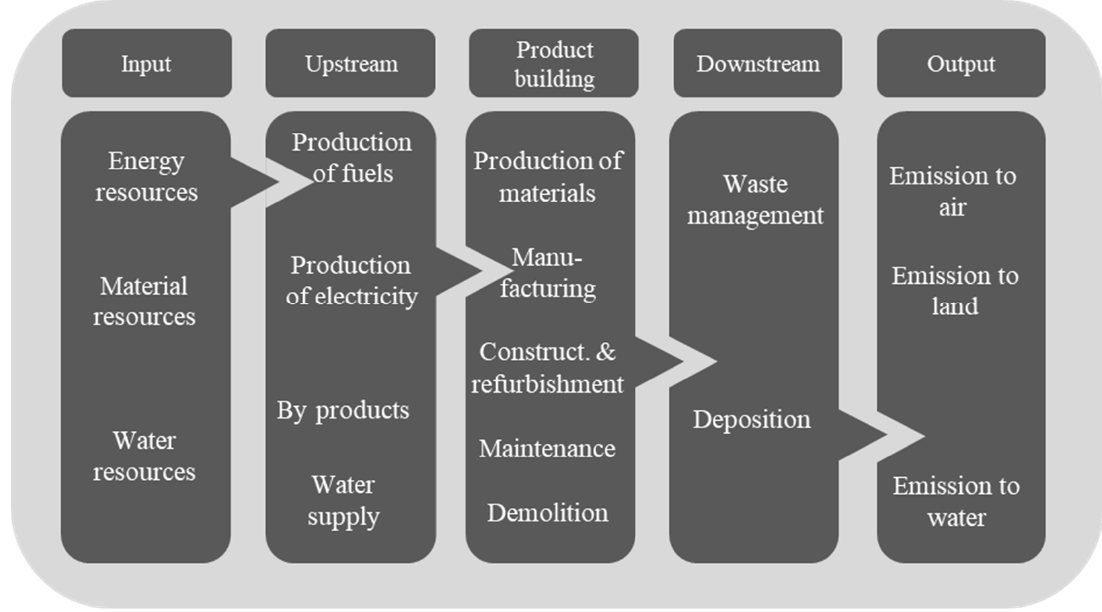
Figure 4. Cradle - to-grave scheme for evaluating the ecological impact of a technology (based on [41–43]). Figure 4. Cradle-to-grave scheme for evaluating the ecological impact of a technology (based on